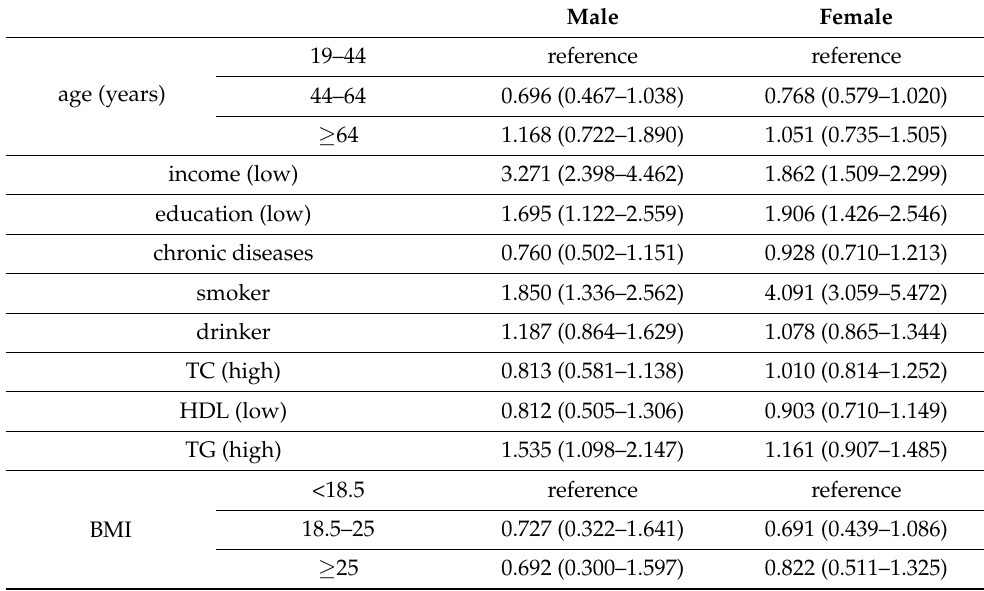
Table 3. Association between serum cholesterol and depression according to sex.